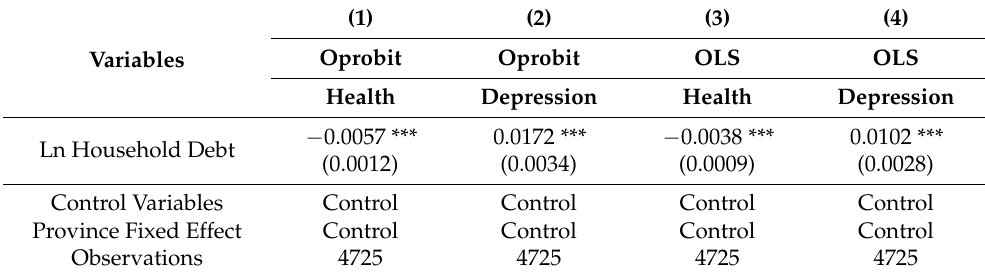
Table 7. Empirical results of the robustness